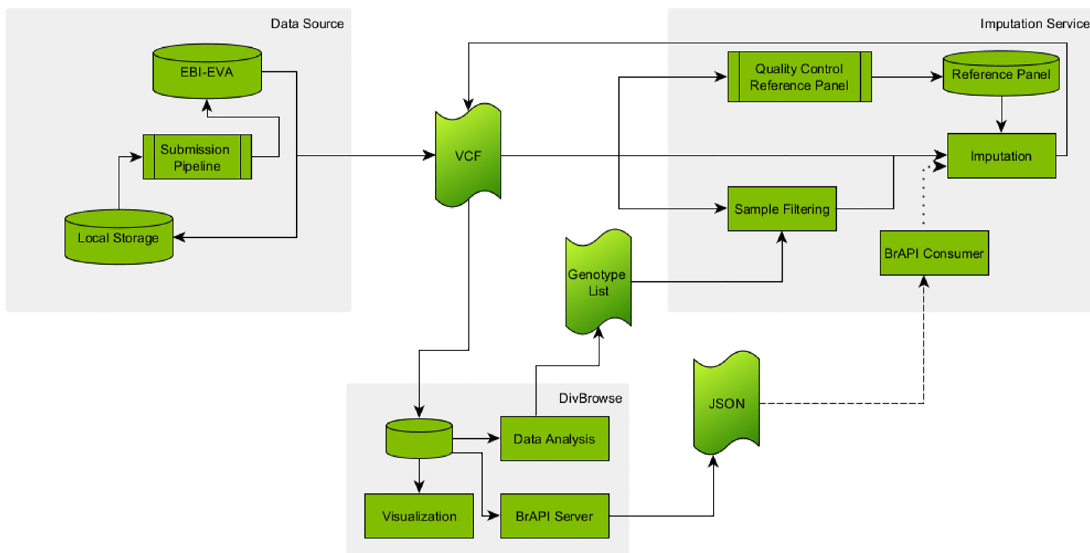
Figure 2: Depiction of the extended imputation workflow. Data from either public or local databases are provided as VCF files. DivBrowse can be used to perform data analysis for sample filtering, to make the data available via BrAPI or to visualize it. The imputation service includes the actual imputation, the filtering of VCF files, the pre-processing of reference panels and the planned processing of variant matrices from BrAPI endpoints. Solid line: Exists and used; Dashed line: Exists, but not used; Dotted line: Not